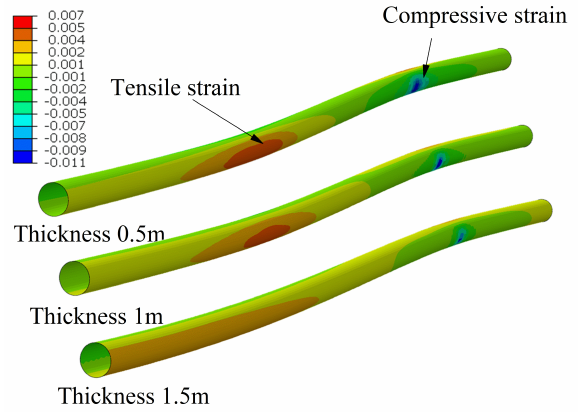
Fig. 9. Ovalisation parameter of pipe with different internal pressures.